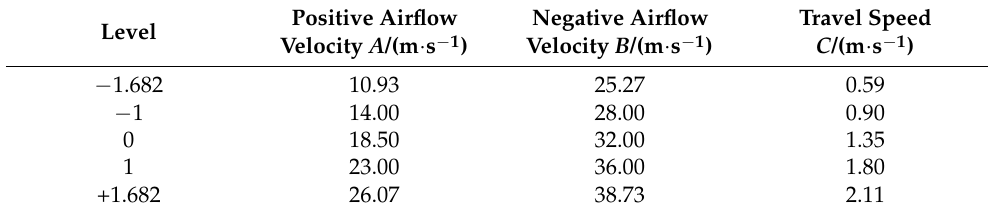
pickup rate, impurities rate, damage rate The interval levels of experimental influencing factors A , B , and C were encoded according to the central composite design method [24,25]. Table 3 shows the levels of the factors for the performance evaluation tests. Table 3. Factors and levels for the performance evaluation tests of the positive and negative synergistic airflow-type jujube fruit harvester (P-N JH).